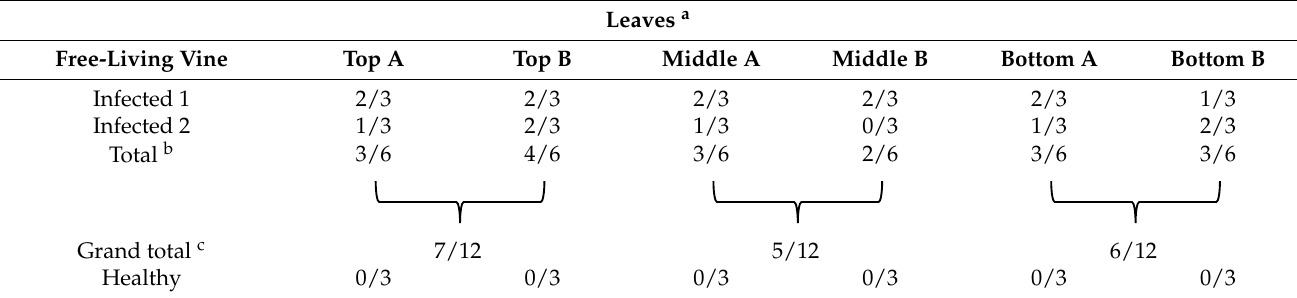
Table 1. Distribution of grapevine red blotch virus (GRBV) in Vitis californica hybrid vines. Leaves a Free-Living Vine